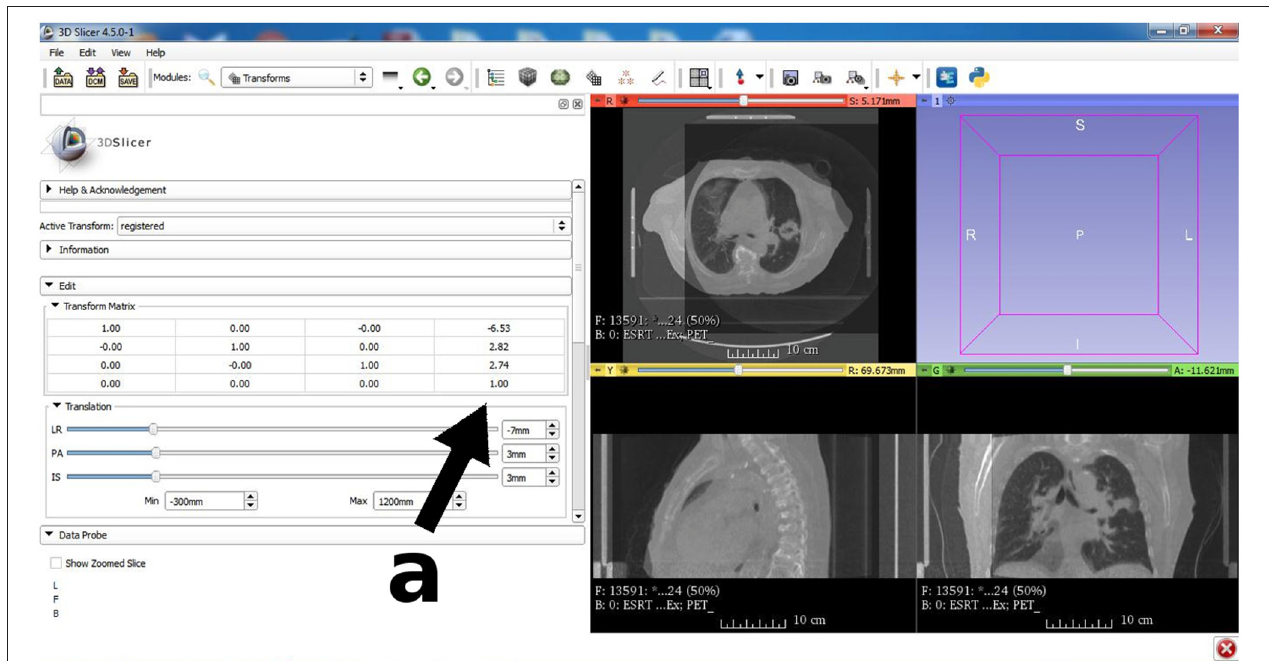
FIGURE 5 | An important image processing tool for the research community is 3D Slicer (www.slicer.org). The image registration module is similar to Figure 4 , but here a fusion of a diagnostic CT is shown together with a cone-beam CT acquired prior to radiation therapy treatment. Fusion of diagnostic grade CT for radiation therapy planning and low quality pre-fraction CBCT is a widespread application in routine quality control for fractionated radiotherapy despite the fact that patient specific molds and other fixation measures are taken. A closer look at the transformation matrix (see arrow a) reveals that no correction with respect to rotation was necessary, but a spatial translation by ( − 6.5, 2.8, 2.7) T mm had to be carried out to ensure that the target region is aligned with the treatment